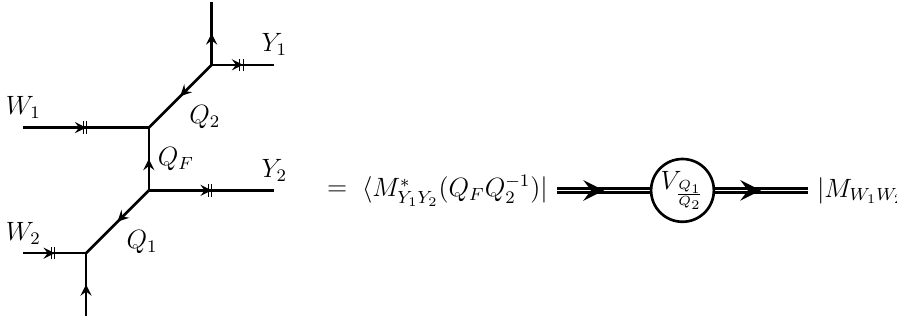
Figure 1 . The correspondence between re(cid:12)ned topological string amplitudes and vertex operators of CFT. Double lines in the r.h.s. denote the CFT Hilbert space on which Vir q;t (cid:8) Heis algebra acts. On the l.h.s. it corresponds to the two horizontal lines. The circle in the r.h.s. represents the vertex operator corresponding to the intersection with the vertical line in the toric diagram in the